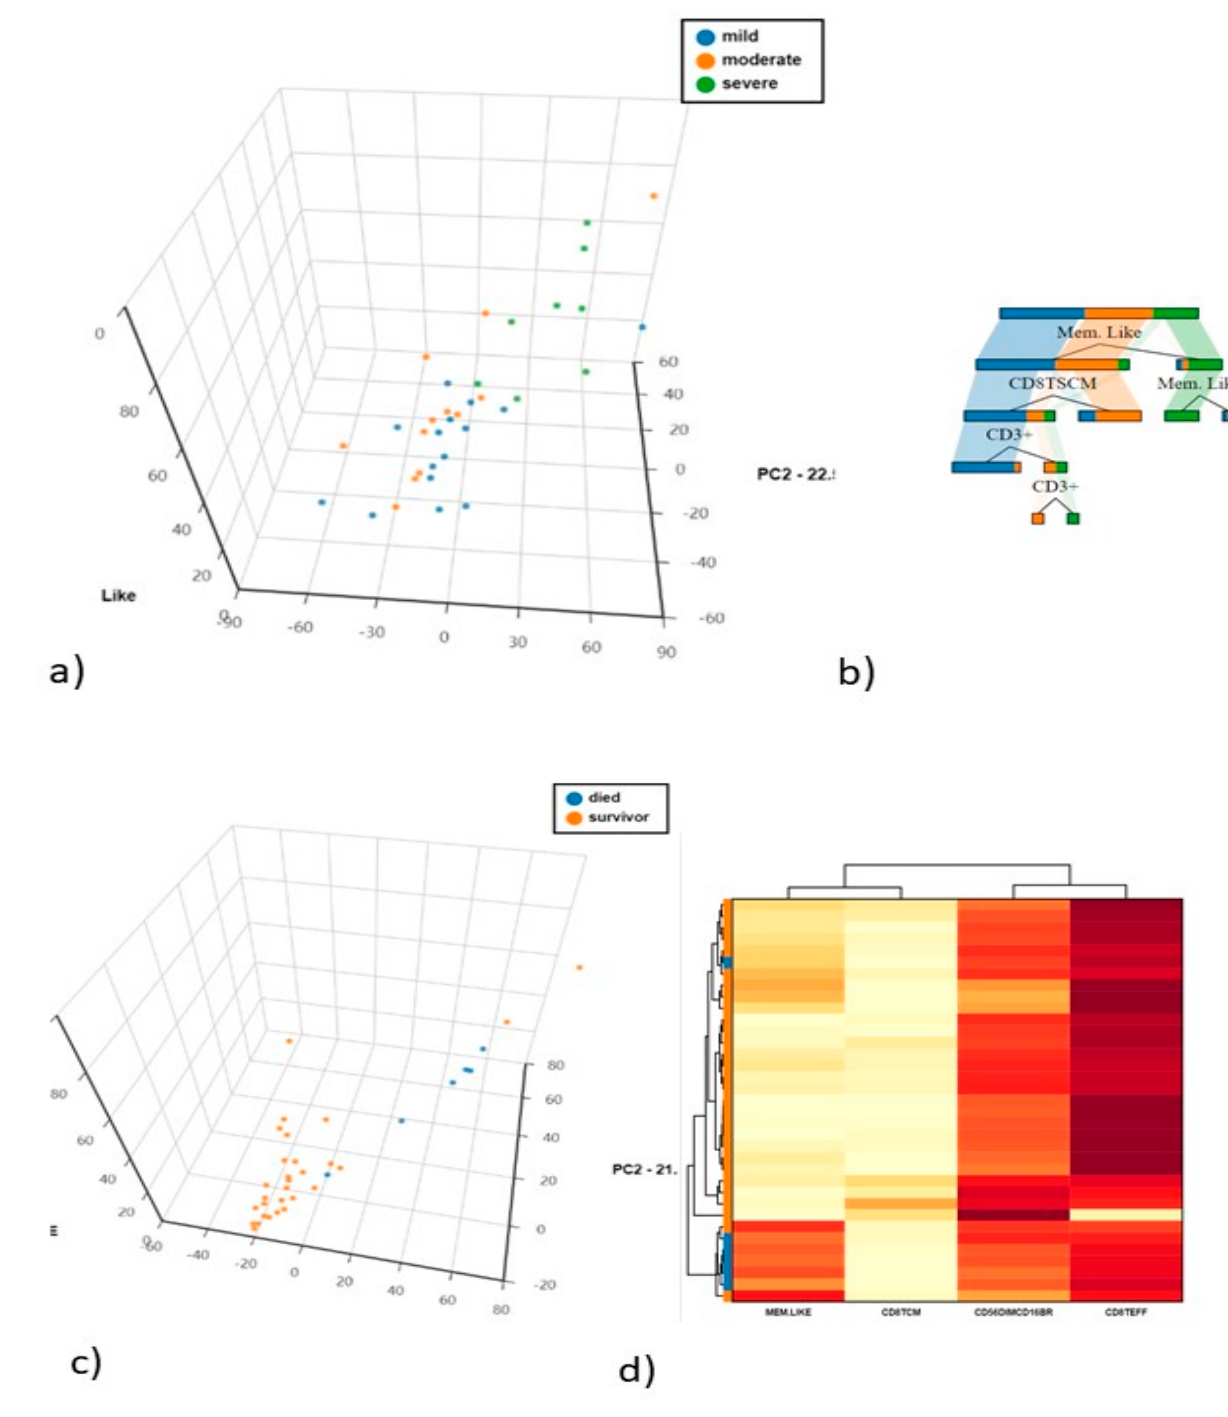
Figure 5. ( a ) Principal Component Analysis (PCA) of NK cells and T cell subsets ( b ) The cellular subsets of patients were employed to create a decision tree model for the detection of best clustering variables between the two groups. ( c ) Principal Component Analysis (PCA) of NK cells and T cell subsets between died and survivors COVID-19 patients ( d ) The heat map analysis of the best discriminatory variable between died and survivors COVID-19 patients. ROC curves were plotted to assess the discriminatory values of cell percentages and to determine sufficiently sensitive and specific cut-off values. CD56 dim CD16